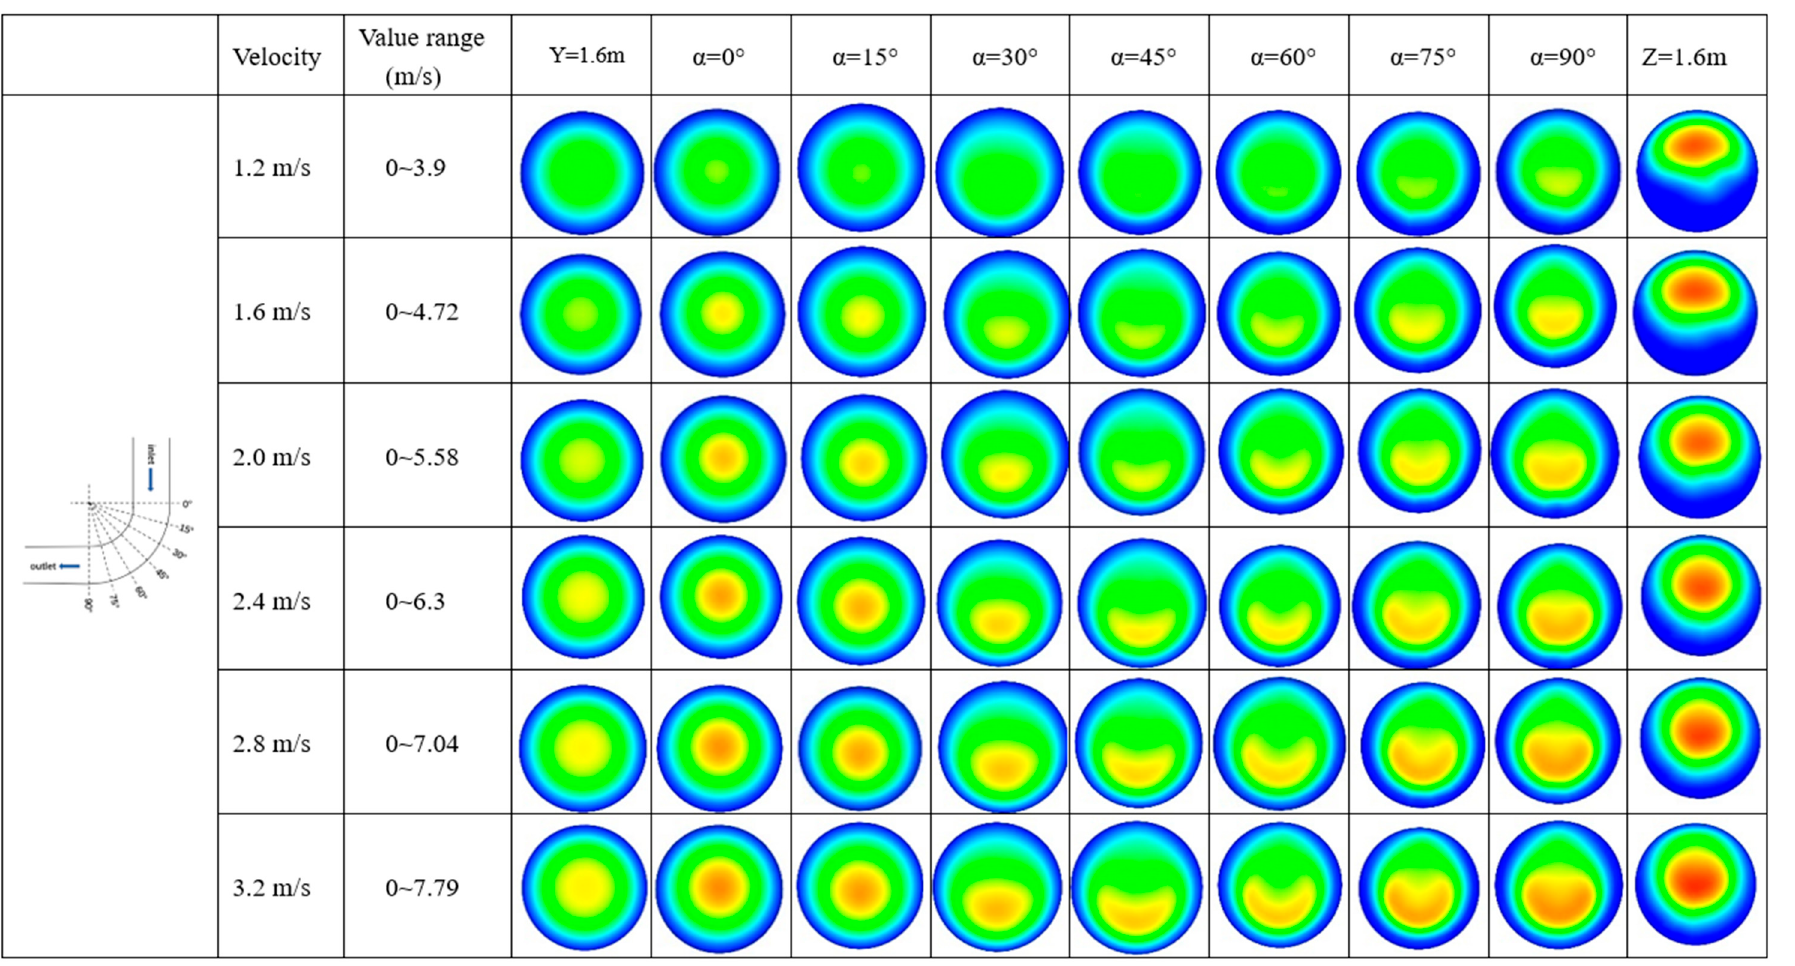
Figure 8. Cross-sectional contours of velocity distribution of CPB at vertical–horizontal bend pipe.